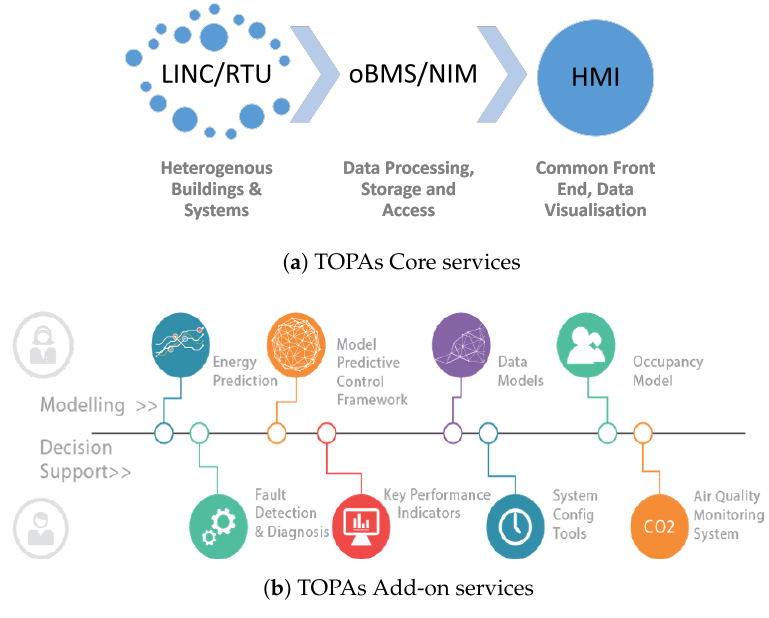
Figure 1. TOPAs core and add-on